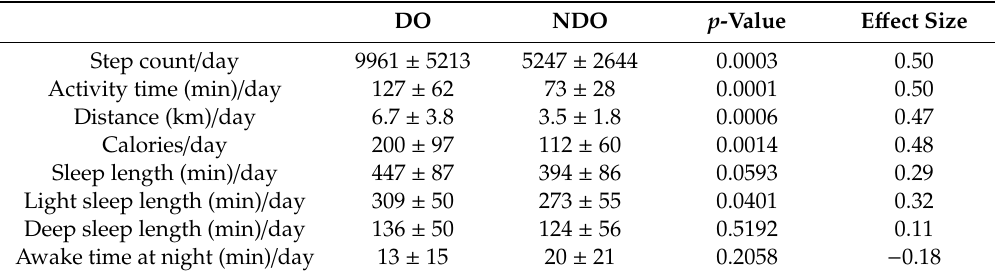
Table 2. Comparing the DO and the NDO using data from accelerometer, mean ±